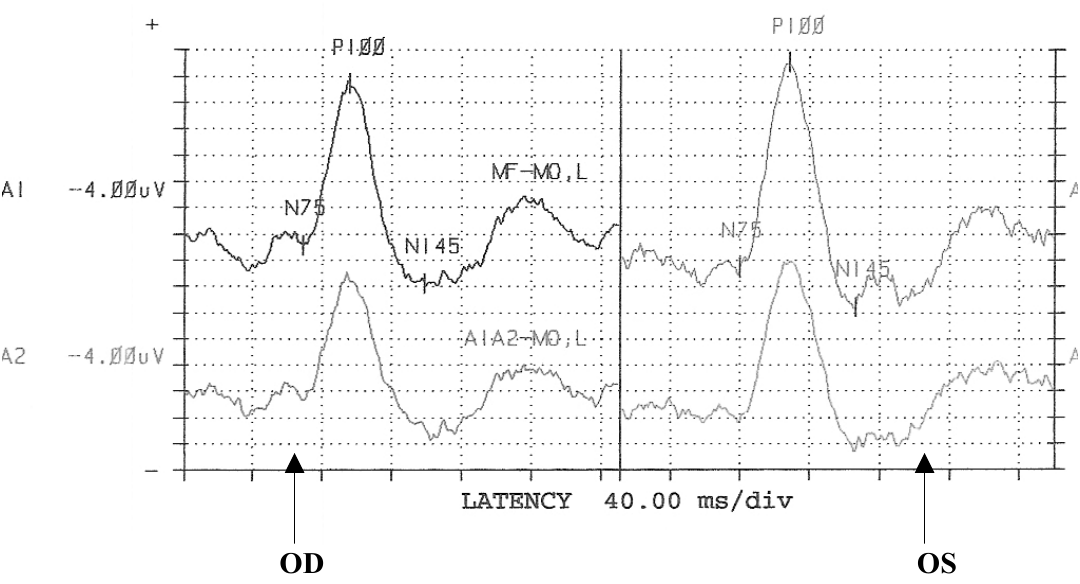
FIGURE 2. Although the morphology of the VEP improved in both responses to 15’ checks and 31’ checks after treatment with IVIG, observe that the P100 latencies in both cases were prolonged (A1 = 15’ checks; A2 = 31’